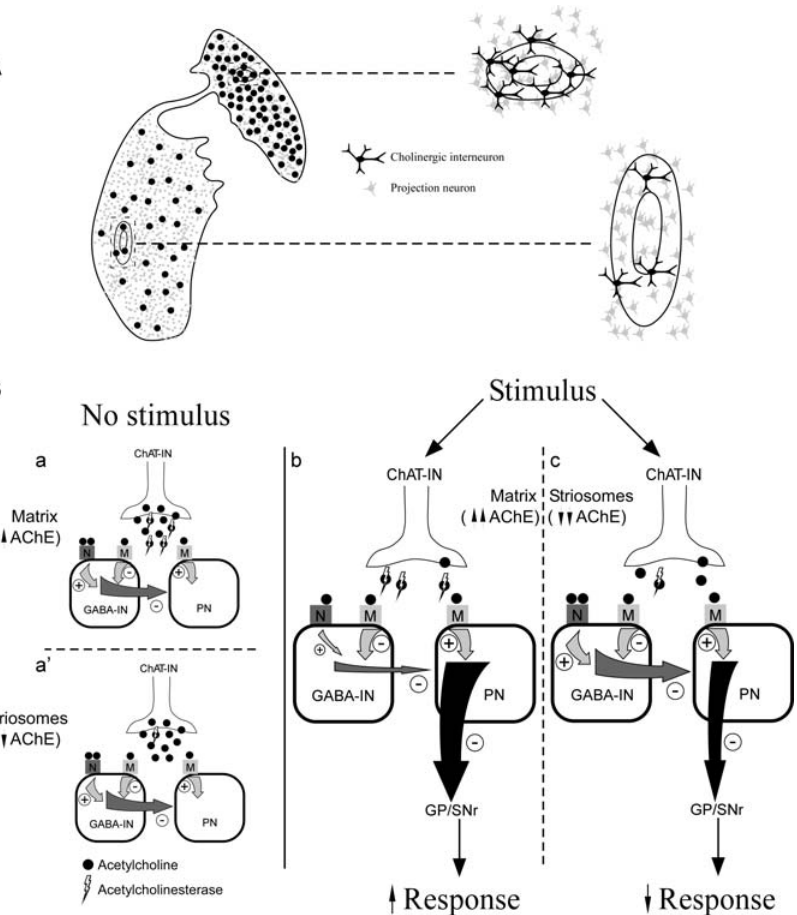
Figure 6. Schematic drawings with functional considerations on the ChAT-ir interneurons. A , difference in the density of cholinergic interneurons between the CN and Put. ChAT-ir neurons populate the matrix and the striosomes in the CN and Put but the number of these cells in the two compartments is higher in the former than in the latter. In both striatal components, the cholinergic interneurons abound at the boundaries between the two major compartments and the two striosomal regions. B , Variation in the activity of the cholinergic neurons defined as TANs depending on: 1, the presence or absence of a reward-associated stimulus and 2, their location in the matrix or within a striosome. a–a 9 , without stimulus the TANs constantly release ACh, which exerts a dual control on GABAergic interneurons through the nicotinic and muscarinic receptors. Due to the large amount of ACh release by these cholinergic neurons, the greater or lower amount of AChE might not be a limiting factor for the activation of the GABAergic interneuron cholinergic receptors. b–c , in the presence of a stimulus the amount of ACh released by the TANs decreases. If ACh is released in the matrix, the high AChE content of this milieu might stop the ACh signal very rapidly at the synaptic cleft, thereby avoiding nicotinic receptor activation on the GABAergic interneurons, and, therefore, facilitating the discharge of projection neurons. If the ACh release is inside a striosome, its low AChE content could facilitate activation of the nicotinic and muscarinic receptors on the GABAergic neurons, which, in turn, would inhibit the projection neurons. ACh, acetylcholine; AChE, acetylcholinesterase; ChAT-IN, cholinergic interneuron; GABA-IN, GABAergic interneuron; GP, globus pallidus; M, muscarinic receptor; N, nicotinic receptor; PN, projection neuron; SNr, substantia nigra pars reticulata . doi:10.1371/journal.pone.0001174.g006 by the TANs decreases in the presence of a stimulus [10]. If the would vary depending on whether the ACh release by these ACh is released in the matrix, the high AChE level might rapidly neurons is in the matrix or the striosomes, since these two terminate the ACh signal and avoid the activation of the nicotinic compartments have different acetylcholinesterase (AChE) con- receptors. In contrast, if the ACh release were inside a striosome, the tents. This enzyme, which hydrolyzes ACh into choline and acetic low AChE content of this compartment could facilitate ACh acid, is much more abundant in the matrix than in the striosomes activation of the same receptors (Fig. 6 B ). When the nicotinic [82]. Although the position of the ChAT-ir cell body does not receptors of the GABAergic interneuron are activated, the indicate unequivocally where the ACh is released, the location of interneuron would have a powerful inhibitory effect on the striatal cholinergic interneurons within the matrix and the striosomes, as projection neuron. However, if only the muscarinic receptors of the well as in the borders between these compartments, leads to interneuron were activated, the projection neuron would not be assume that ACh release may happen in both the matrix and the inhibited. As a result, the striatal projection neurons would be more striosomes. In the absence of stimulus, TANs constantly release strongly suppressed by the GABA interneurons in the striosomes ACh, which exerts a dual control on GABAergic interneurons than in the matrix and, therefore, the influence on the output through nicotinic and muscarinic receptors [4,13,83]. Nicotinic structures would vary considerably between the two compartments receptor activation requires more ACh than that needed to depending on their relative amount of ACh (Fig. 6 B ). activate muscarinic receptors [84]. The amount of ACh released